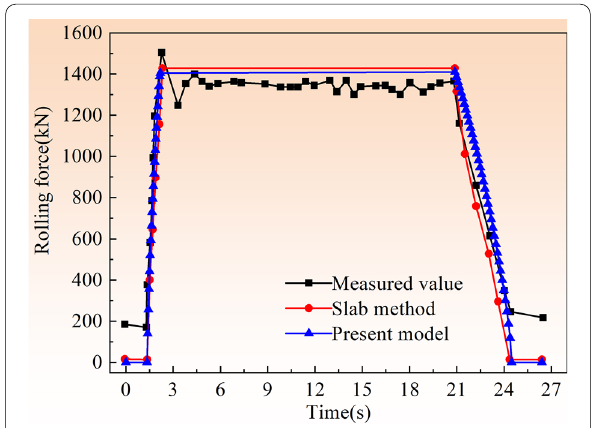
Figure 8 Comparison of roll separating force in a TRB